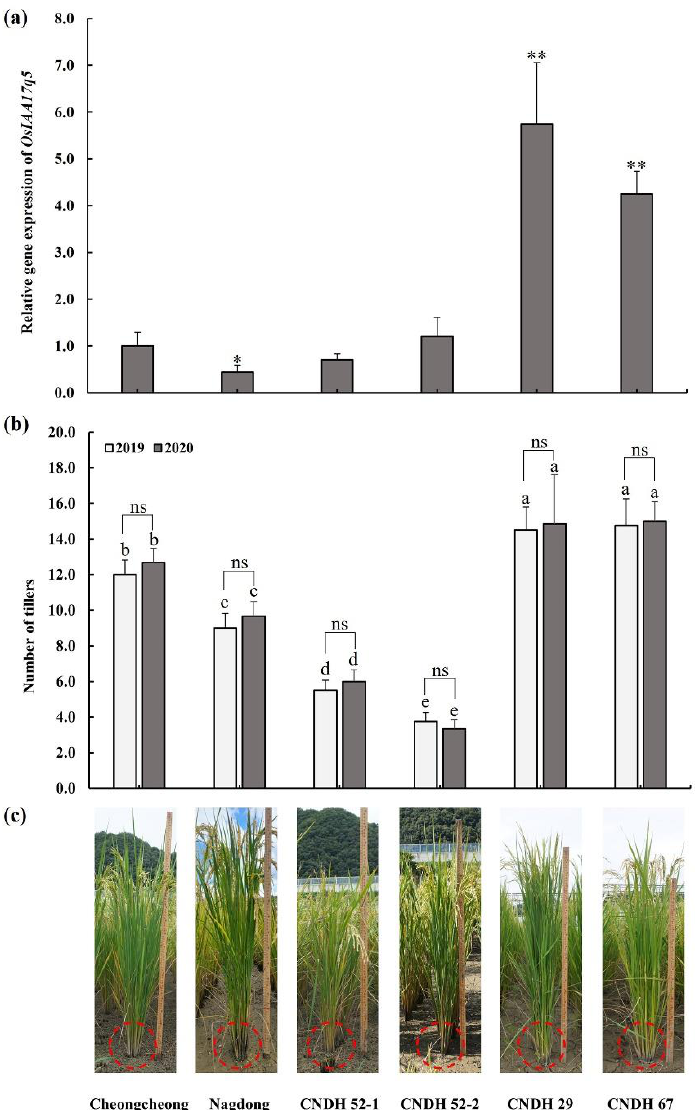
Figure 9. Analysis of relative expression levels for OsIAA17q5 and morphological characters in the CNDH lines and parental lines. ( a ) The expression of OsIAA17q5 in Cheongcheong, Nagdong, CNDH 52-1, CNDH 52-2, CNDH 29, and CNDH 67. Values are means ± SD ( n = 3). * p < 0.05, ** p < 0.01 (two-tailed Student’s t-test). ( b ) Column diagrams showing the number of tillers in 2019 and 2020. ns, no significant difference, (two-tailed Student’s t-test). Statistical comparisons were made using one-way variance analysis/Duncan’s multiple range test. The different letters above the column represent a statistically significant difference at p < 0.05. Values are means ± SD ( n = 6) ( c ) Morphological characters in the CNDH lines and parental lines. (Measuring ruler = 1m).